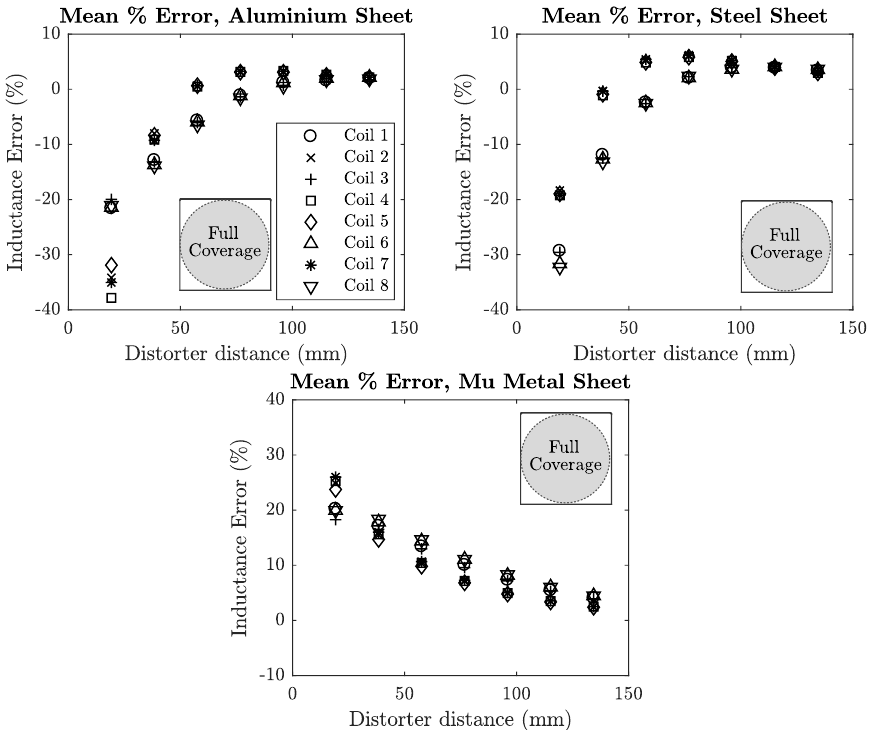
Figure A1. Mutual inductance error plots for planar sheet distorters spanning the area of all transmitter coils. The mu-metal sheet contributes positively to the overall inductance of the transmitter over all